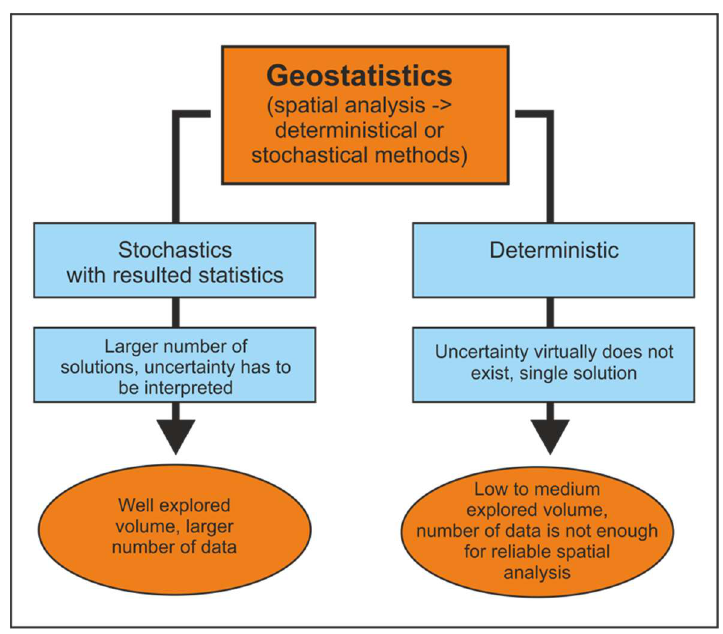
Figure 1. Relation between geostatistical approach and number of data elements.